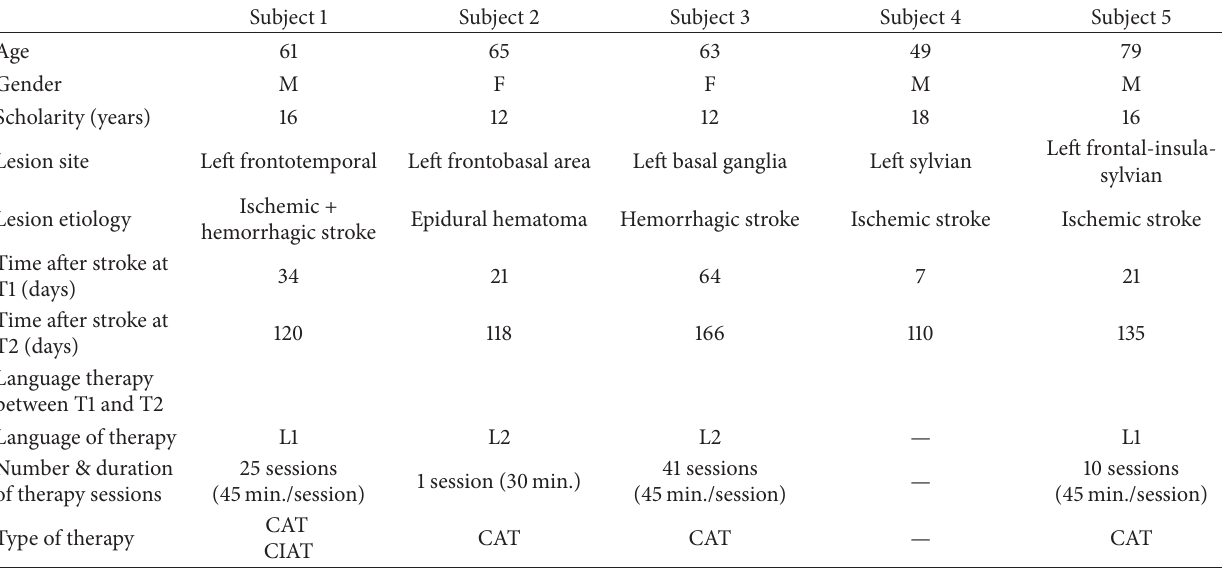
Table 2: Demographic